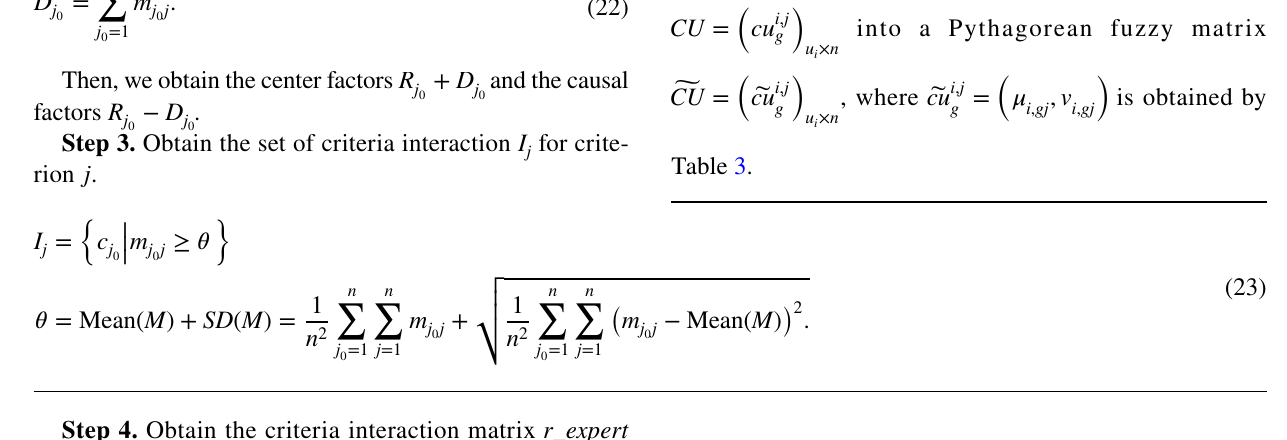
Step 4. Obtain the criteria interaction matrix r _ expert provided by the expert.